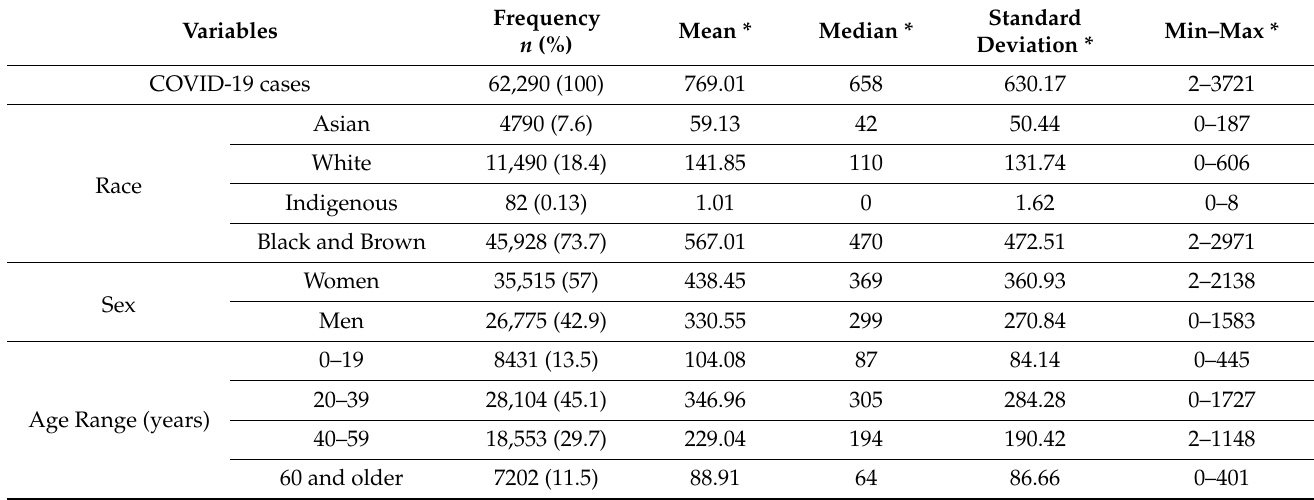
Table 2. Description of notified cases of COVID-19 in the urban